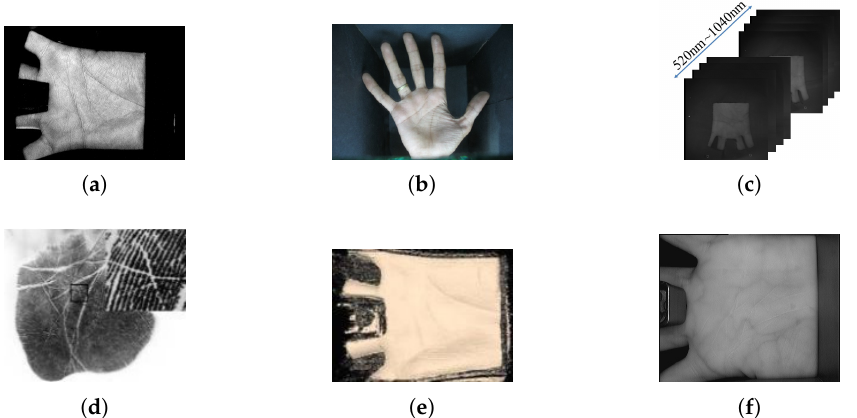
Figure 2. Categories of palmprint images from ( a ) contact-based, ( b ) contactless, ( c ) hyperspectral, ( d ) high-resolution, ( e ) 3D, and ( f ) palm–vein palmprint databases, respectively. Up to now, some reviews have analyzed the development of palmprint